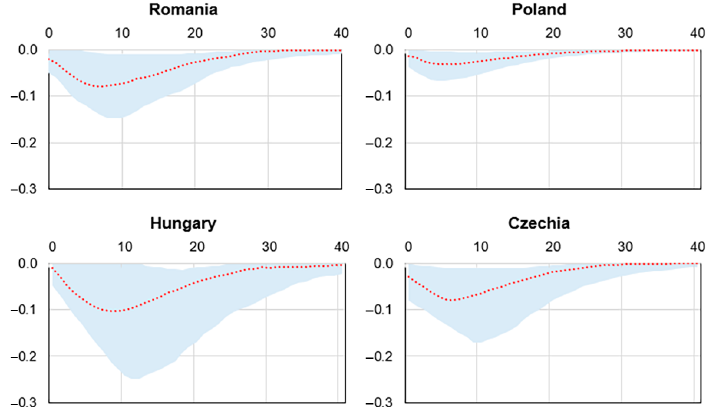
Figure 2. Impulse response functions of a one standard deviation supply shock in Euro Area on the selected CEE countries real economic growth (source: authors’ calculations)